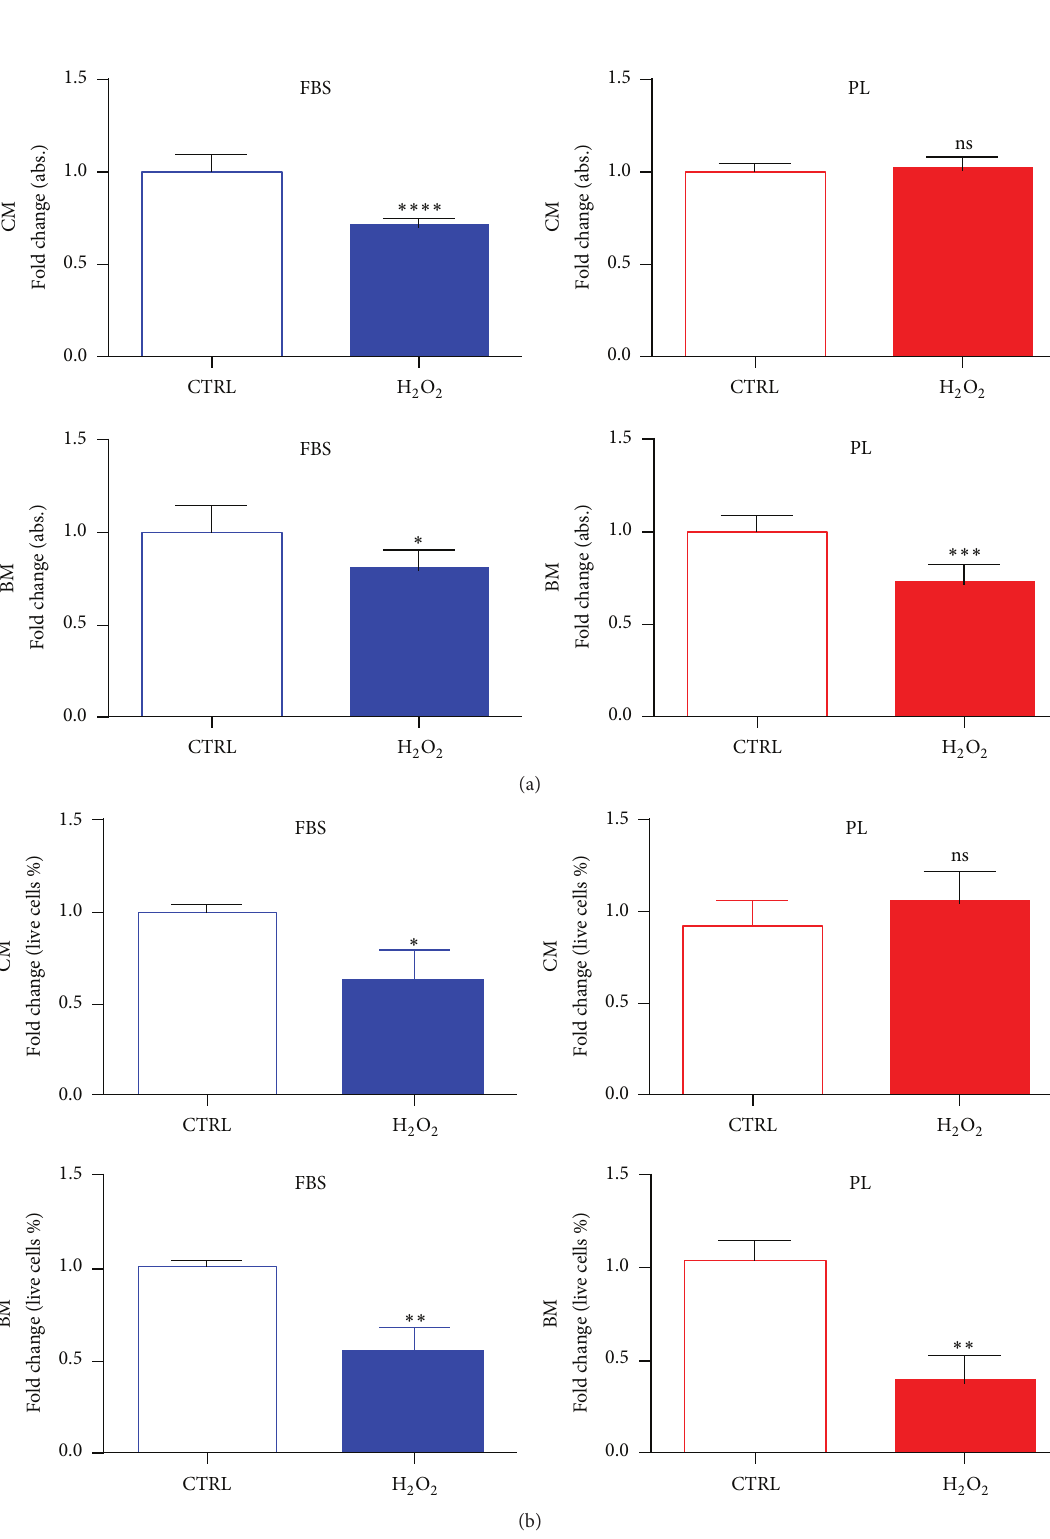
Figure 4: Impact of H 2 O 2 on cellular viability is influenced by PL in culture. (a) Metabolic activity of cultures measured by PrestoBlue conversion 6 hrs after the treatment with H 2 O 2 . Data are expressed as mean + SD, 𝑛 = 3 , derived from 2 experiments. (b) Automatic viable cell counts after 6hrs of treatment. Data were normalised to median value of control samples and shown as mean + SD, 𝑛 = 3 . To determine significant results, the unpaired 𝑡 -test was performed ( ∗ 𝑃 < 0.05 ; ∗∗ 𝑃 < 0.01 ; ∗∗∗ 𝑃 < 0.001 ; ∗∗∗∗ 𝑃 < 0.0001 ). CM, treatment performed in complete medium; BM, treatment performed in basal